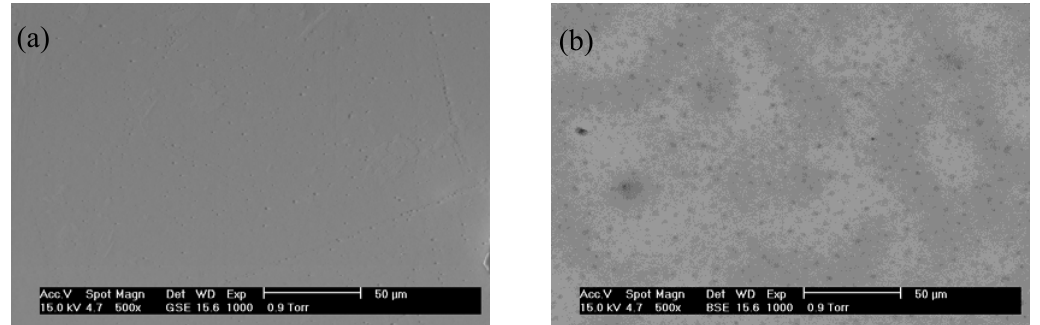
O :Eu 3+ F127 modified 2 3